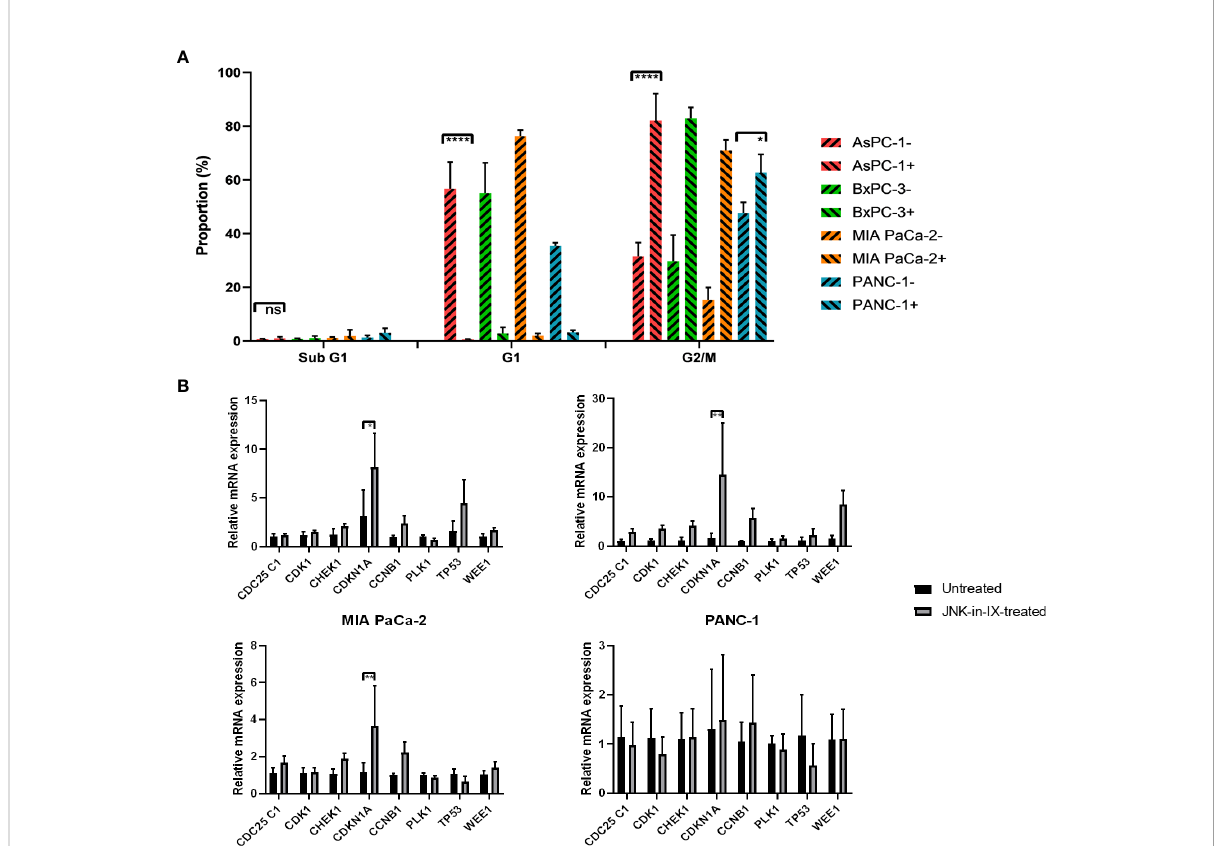
FIGURE 5 (A) Cell cycle analysis. After treatment with JNK-in-IX in the previously determined concentrations for 48 h, 10 6 PC cells were harvested, fi xed, and stained with PI staining buffer. Afterwards, data were acquired using a fl ow cytometer. Cell cycles were normalized to the untreated control of which proportions are presented. All cell lines show a signi fi cant decrease in the G1 phase and a corresponding increase of cells in G2/M phase (p < 0.0001 for all cells except PANC-1, p < 0.05 for PANC-1). (B) mRNA expression of cell cycle regulators. Cyclin Dependent Kinase 1 (CDK1), Cyclin B1 (CCNB1), CDC25C1, Polo-like Kinase 1 (PLK1), Checkpoint Kinase 1 (CHEK1), p21 (CDKN1A), p53, and Wee1 expression in pancreatic cancer cells treated by JNK-in-IX was tested by qPCR. Data are shown as fold changes with respect to the untreated group (2- DD Ct, mean ± SEM, n = 3). GADPH was used as the internal control. *p<0.05, **p < 0.01, ****p <